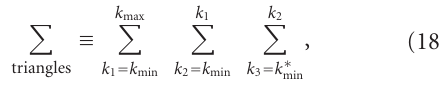
ideal geometry galaxy survey of volume V = 10h − 3 Gpc 3 and a galaxy number density of n g = 5 × 10 − 3 h 3 Mpc − 3 at redshift z = 1 (dashed, red lines) and z = 3 (continuous, blue lines) are shown. The negligible di ff erence